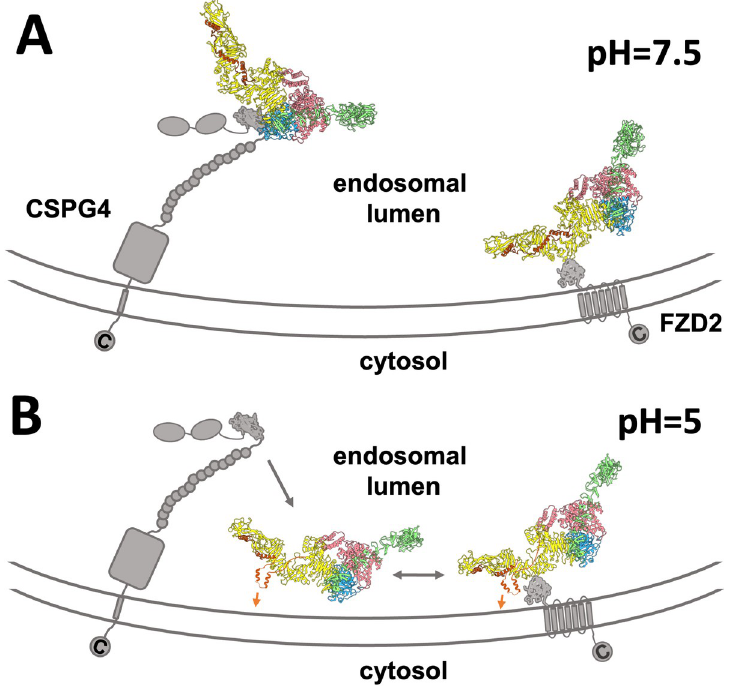
Fig 4. The proposed model of the recognition of CSPG4 and FZD2 by TcdB and its dissociation upon endosomal acidification. (A) TcdB (shown as a ribbon model) binds to the receptors (gray cartoon), CSPG4 and FZD2, before endosomal acidification. The proposed pore-forming helices of TcdB are shown as orange ribbon models. (B) TcdB dissociates from the receptors and the pore-forming helices rearrange. Gray arrows indicate the dissociation of TcdB. Orange arrows suggest the insertion of pore-forming helices into the endosomal membrane. CSPG4, chondroitin sulfate proteoglycan 4; FZD2, frizzled-2; TcdB, Toxin B.